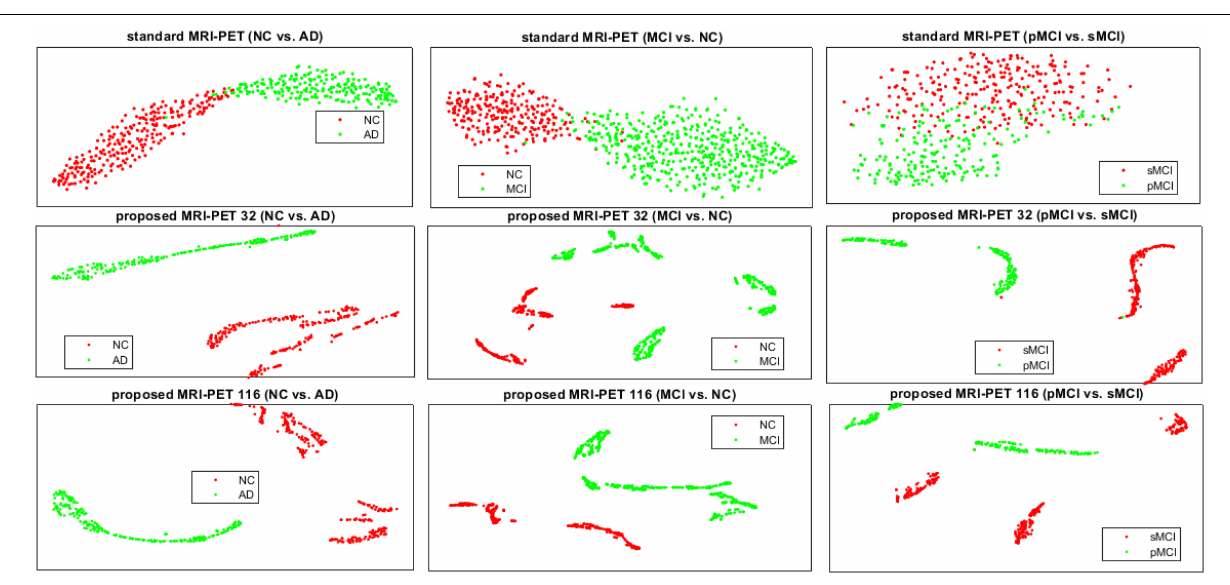
we integrate the original image features from MRI and PET